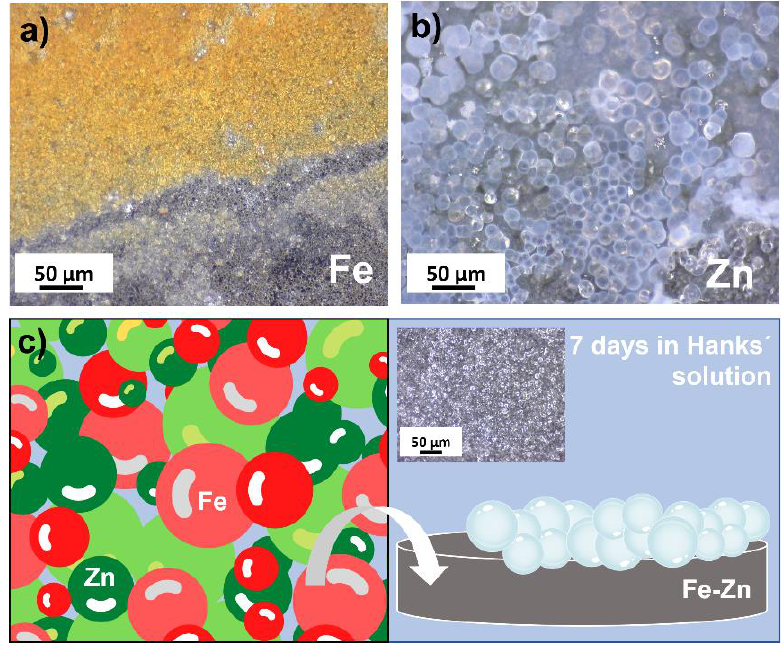
Figure 9. Corrosion products found on the sample made of pure iron (a), pure zinc (b) and schematic representation of corrosion process of the Fe-Zn sample (c).